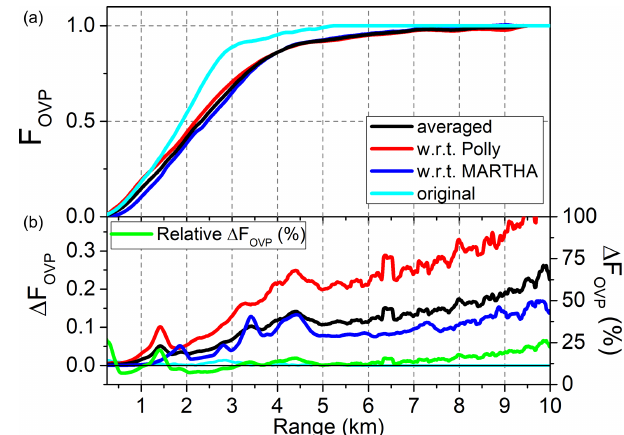
Figure 2. (a) Experimental overlap functions, F OVP , as obtained for two different days from the ratio between the P-MPL RCS profiles with respect to the Polly ( F Polly , red) and MARTHA ( F MARTHA , OVP OVP blue) profiles, together with the averaged function ( F av ) of both OVP of them (black line); the original overlap function as provided by the manufacturer, F original , is also included (cyan line). (b) Errors, OVP (cid:49)F OVP , associated with the OVP function estimation for each com- parison case: P-MPL with respect to Polly (red), P-MPL with re- spect to MARTHA (blue), and the averaged OVP function of both of them (black); the error for F original (cyan) and the relative error OVP for F av (green line) are also OVP